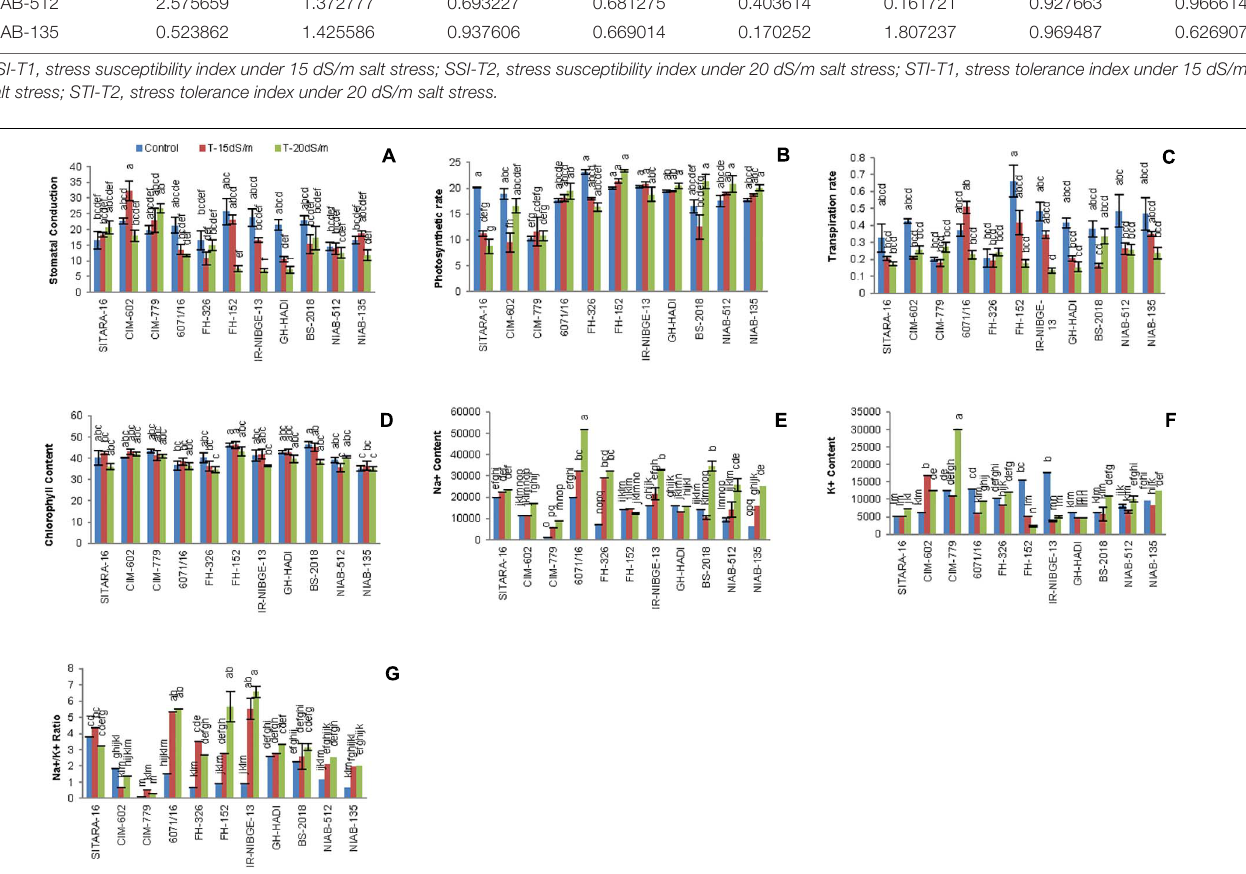
FIGURE 6 | Comparison of panels (A) stomatal conductance, (B) photosynthetic rate, (C) transpiration rate, (D) chlorophyll content, (E,F) Na + and K + content, and (G) Na + /K + ratio between the cotton genotypes under normal and salt stress